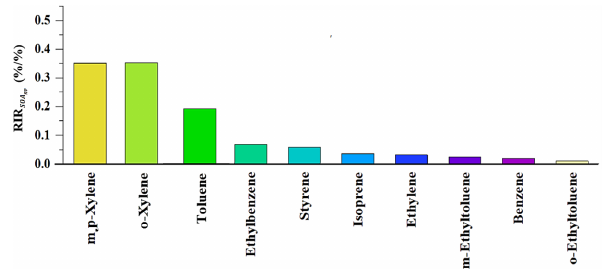
Figure 3. Top 10 VOC precursors with high RIR SOA